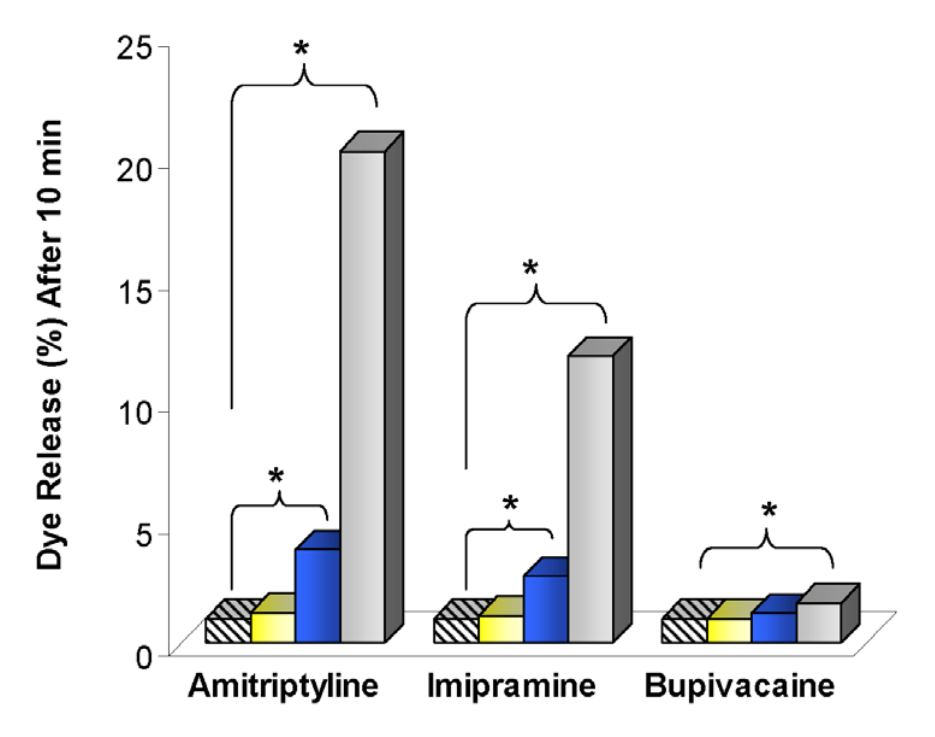
Figure 7. Percent of entrapped calcein released by 95:5 DOPG:DPPE-mPEG-2000 liposomes 10 minutes after exposure to amitriptyline, imipramine, or bupivacaine at drug concentrations of 0 ( ), 8.6 ( ), 38 ( ), and 150 ( ) μ M. Means are shown with n = 2- 4. Marker denotes p < 0.05 (*). Figure adapted from